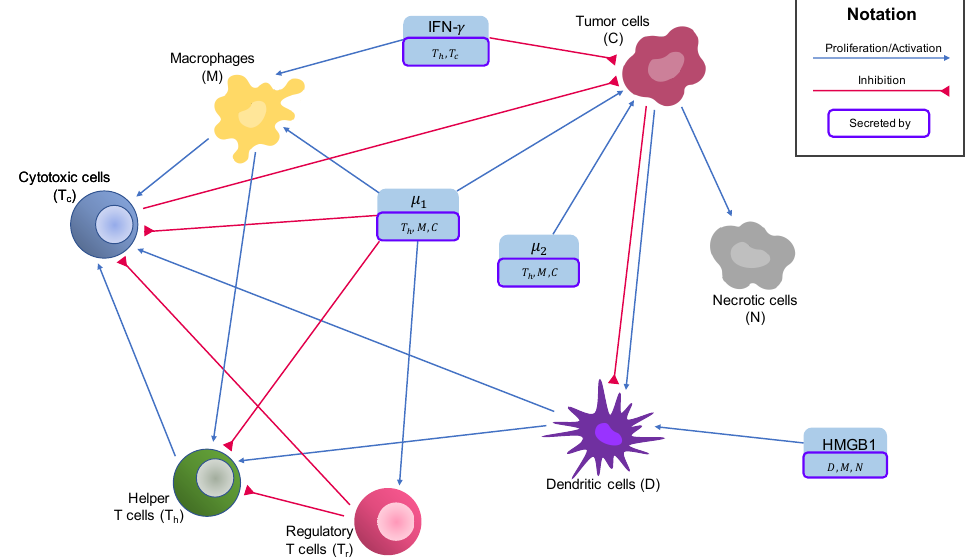
Figure 1. Interaction network of the tumor microenvironment in osteosarcoma . Activations and proliferations are shown by blue arrows, and inhibitions are indicated by red arrows.